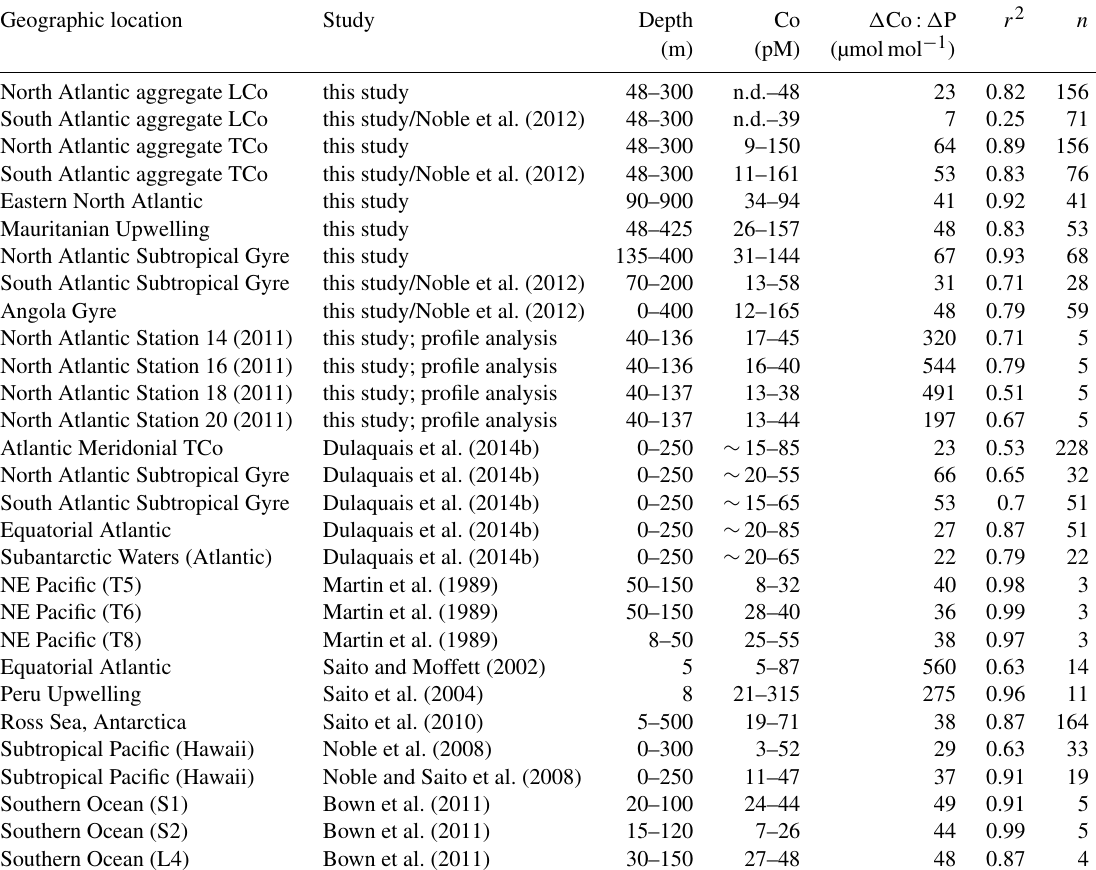
Table 1. Ecological stoichiometries for dissolved cobalt, labile cobalt, and phosphate in the Atlantic Ocean and prior studies. LCo refers to labile cobalt; all other values are total dissolved cobalt (dCo). n.d.: not detected; n : number of observations used. Geographic